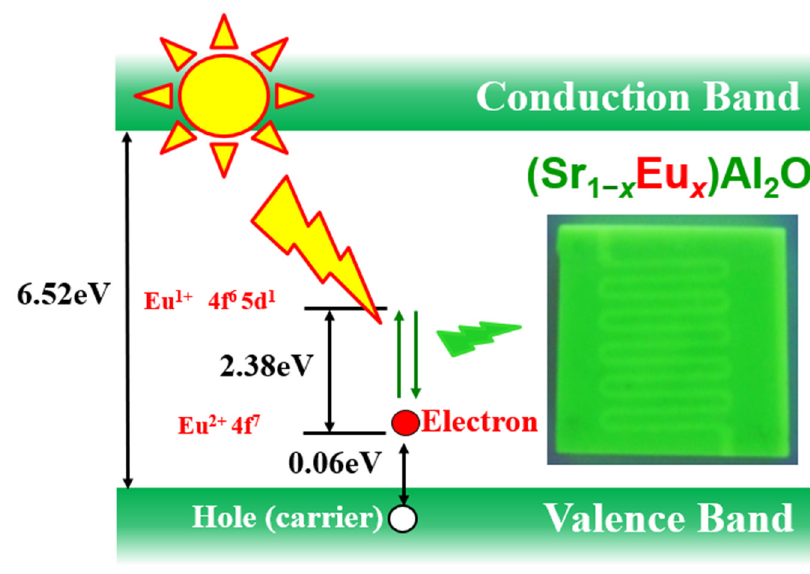
2+ -doped SrAl 2 O 4